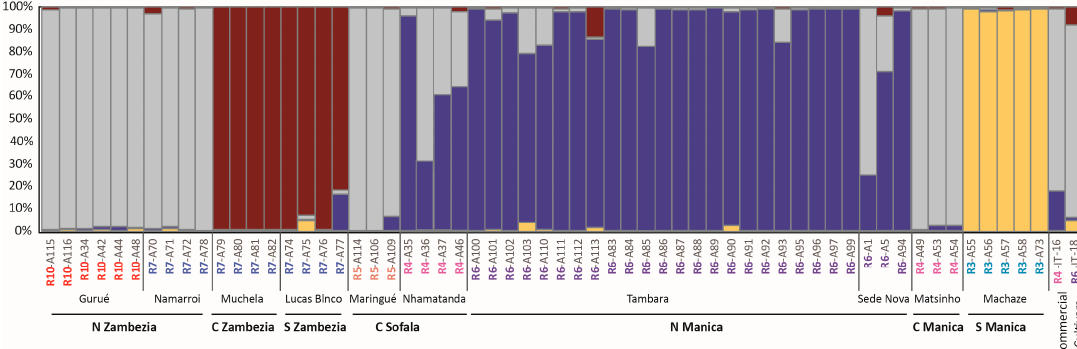
Figure 5. Population structure of Vigna unguiculata based on nine SSRs and using the best assignment result retrieved by STRUCTURE ( K = 4). Each individual sample is represented by a thin vertical line divided into K colored segments that represent the individual’s estimated membership fractions in the K clusters. Landraces and provinces are indicated below. AEZs are indicated in individual labels with different colors for better visualization. The two cultivars are also indicated.